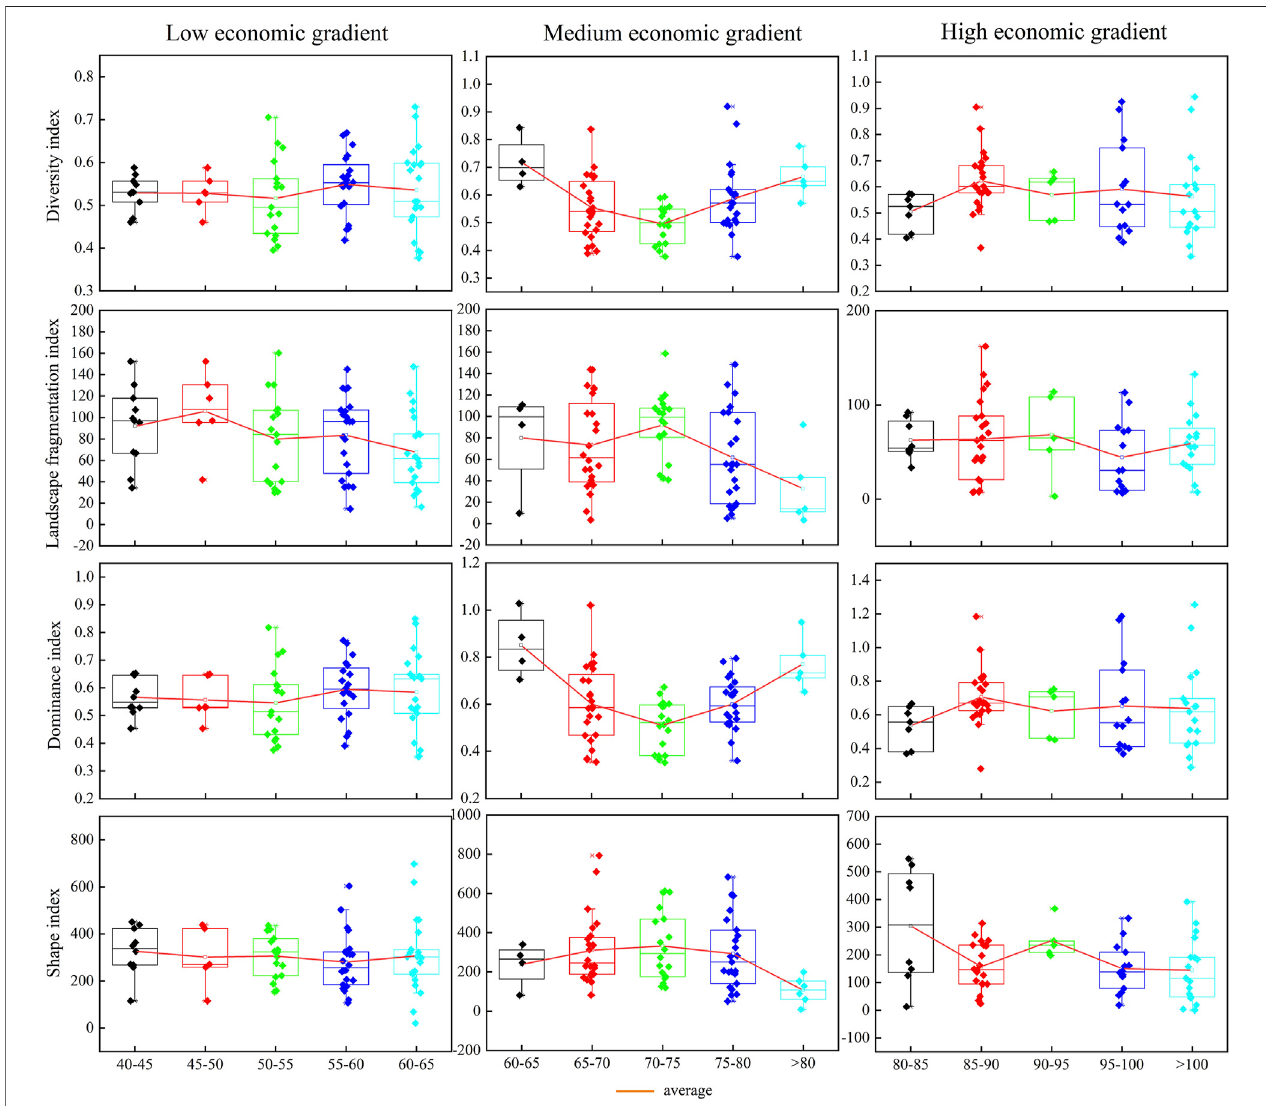
FIGURE 8 | Economic gradient differentiation of the landscape index of